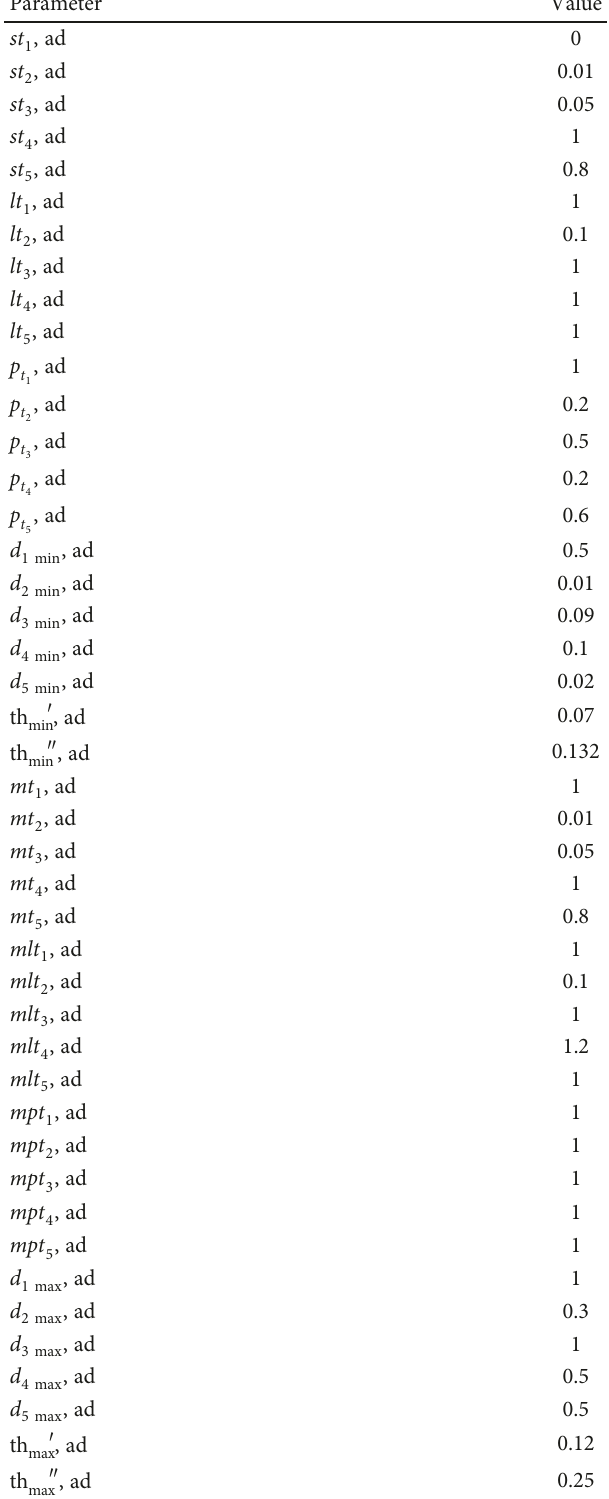
Table 1: Parameters adopted in the modelling of TPS con fi gurations of Figures 5 and